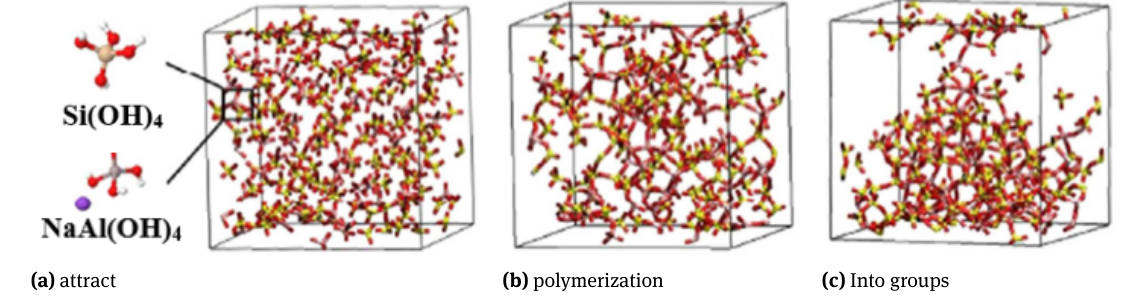
Figure 8: Geopolymer molecular model [50].